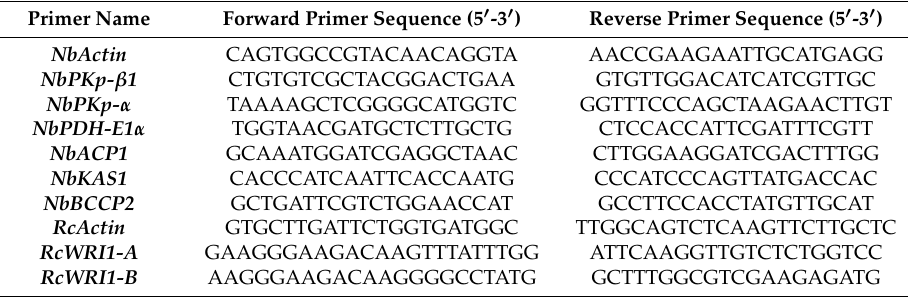
WRI1, and two RcWRI1 expression levels in various castor organs calculated by 2 − Table 1. Primer sequences used for qRT-PCR in this Table 1. Primer sequences used for qRT-PCR in this study.